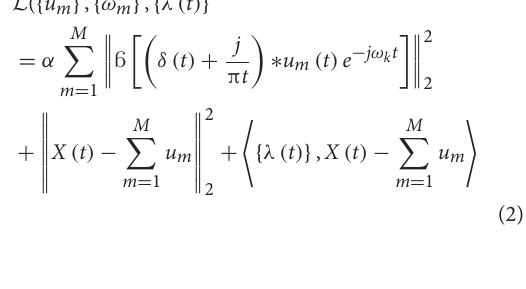
coincides with the focus position of the transducers. Then the ultrasonic signal is obtained after the ultrasonic signal passes through the cottonseed. The ultrasonic signal data is exported and saved as a CSV format file. Finally, the category label (1 or 0) corresponding to each sample is appended to the end of CSV file, where “1” represents the normal cottonseed and “0” represents the cottonseed with slight crack. Each cottonseed sample corresponds to a CSV file, and all CSV files constitute the data set used in this study. The typical ultrasonic signals from intact cottonseed and cottonseed with slight crack are shown in Figure 3 respectively. The amplitude fluctuations of the two types of ultrasonic signals are very similar, so it is very important to extract effective features for classification from these